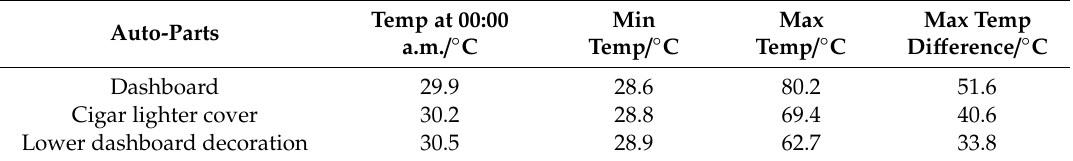
Table 6. Setting glazing transmissivity in different windows.